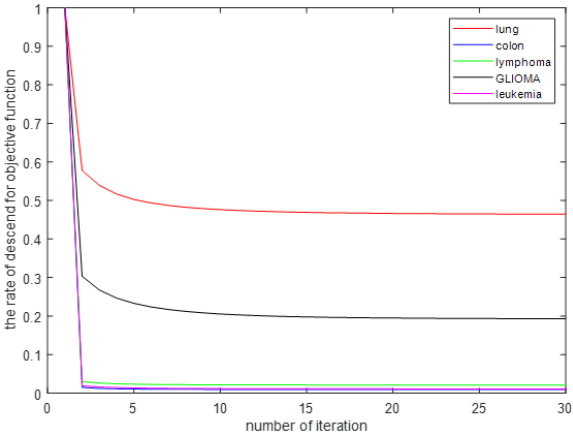
Figure 4. The convergence of MDS-AUFS on five gene